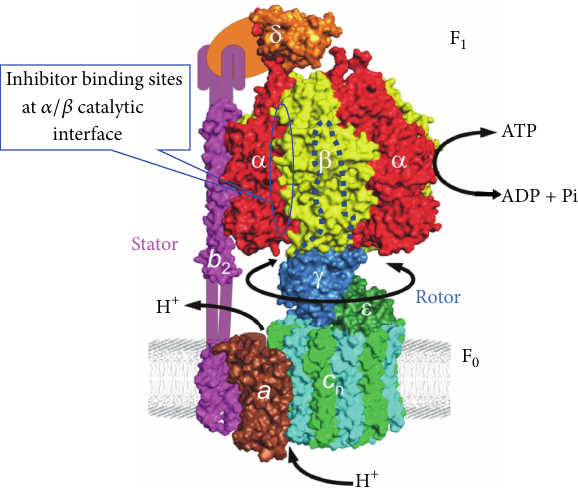
Figure 1: Escherichia coli F 1 F 0 ATP synthase structure: E. coli ATP synthase in the simplest form contains water soluble F 1 and membrane bound F 0 sectors. Catalytic activity ensues at the 𝛼/𝛽 interface of F 1 sector. Many inhibitors also bind to the F 1 sector which comprises five subunits (𝛼 3 𝛽 3 𝛾𝛿𝜀) . The proton pumping occurs at the F 0 sector comprising three subunits (ab 2 c). This structure of E. coli F 1 F 0 ATP synthase is reproduced from Weber [27] with permission; copyright